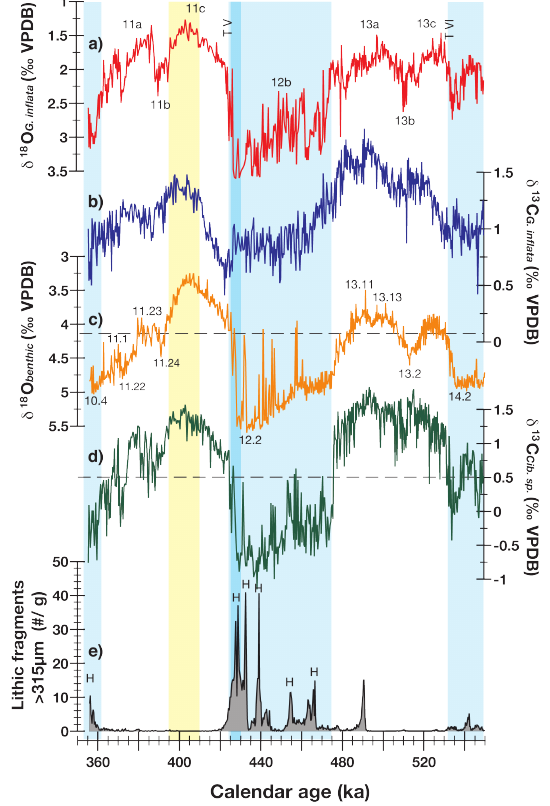
Fig. 3. Records for IODP Site U1313 in the mid-latitude North Atlantic (34: a) G. inflata δ 18 O (‰VPDB; red), b) G. inflata δ 13 C (‰VPDB; blue), c) benthic δ 18 O (‰VPDB; orange), d) epibenthic δ 13 C (‰VPDB; green), and e) lithics concentration (#/g; black). Light blue bars mark glacial MIS 10, 12 and 14; dark blue bar the Heinrich-type event at the end of MIS 12; and the yellow bar the MIS 11 sea level highstand. Substages (e.g. 11c) are indicated on the G. inflata δ 18 O record (a) and isotopic events (e.g. 10.4) on the benthic δ 18 O record (c). Dashed line in c) designates the ice volume threshold of McManus et al. (1999) and in d) the NADW/Antarctic Bottom Water boundary. T IV, V and VI refer to Terminations VI, V and VI. H indicates IRD peaks with Heinrich-type signatures (Stein et al.,